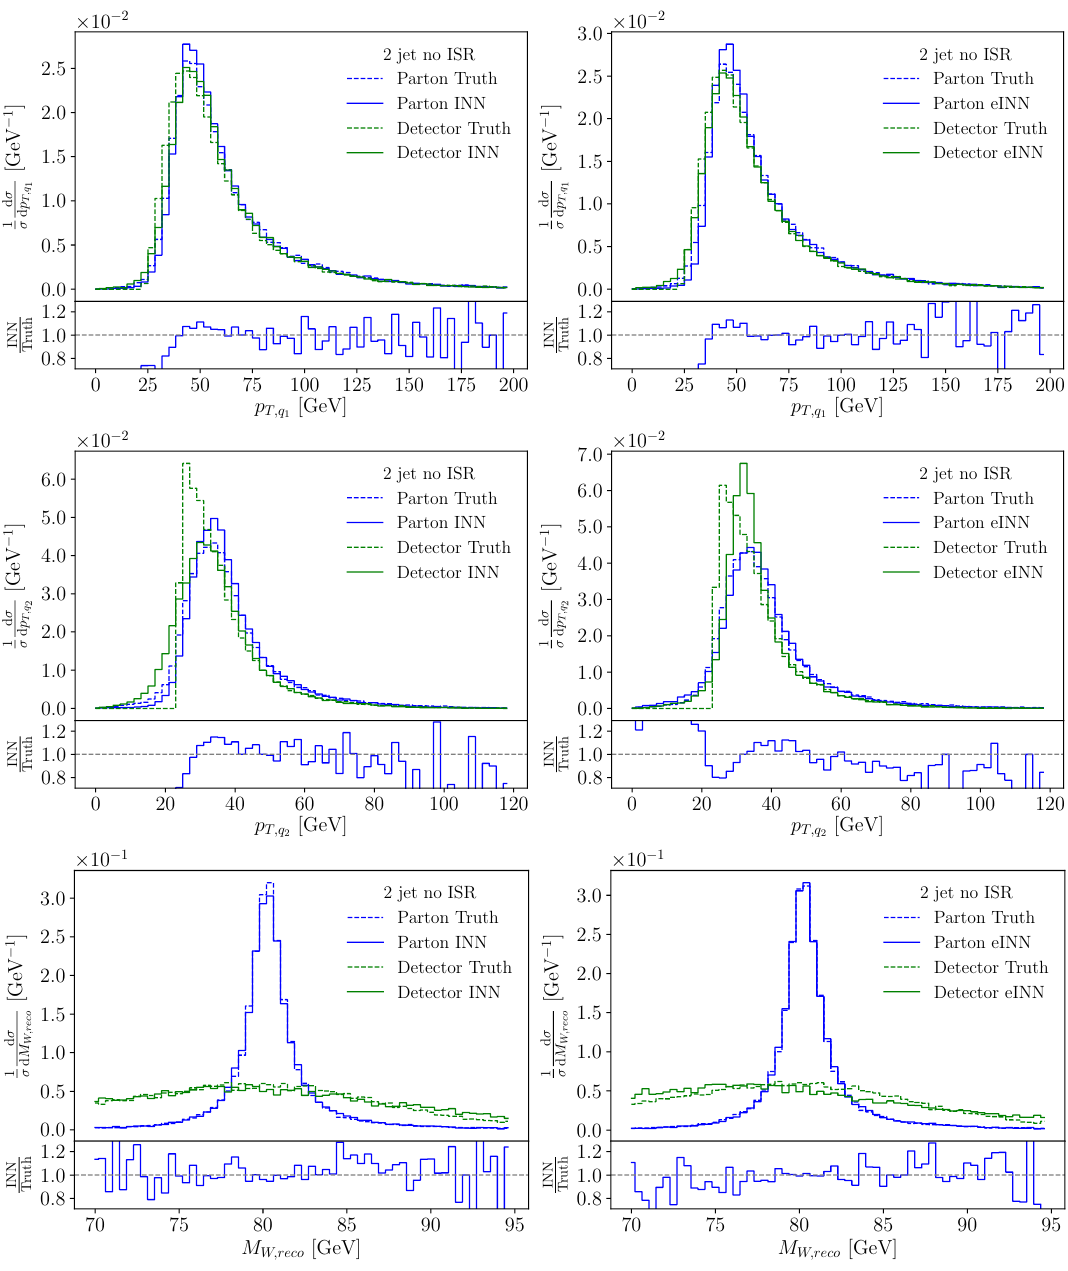
Figure 3: INNed p and M distributions from a naive INN (left) and the noise- T , q W ,reco extended eINN (right). In green we compare the detector-level truth to INNed events transformed from parton level. In blue we compare the parton-level truth to INNed events transformed from detector level. The secondary panels show the ratio of INNed events over parton-level truth. More distributions can be found in the pdf files submitted to the